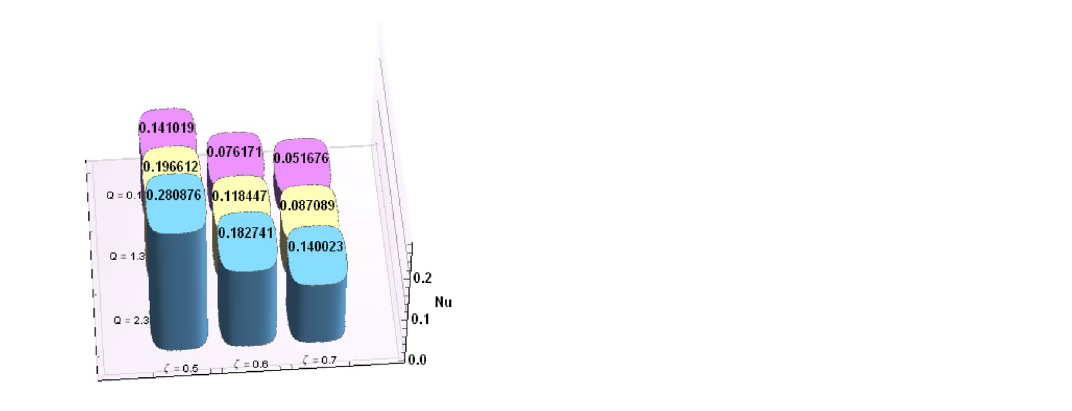
Figure 11. Bar chart representation of Skin friction coefficient and Nusselt number for different parameters using Mathematica 10 software available at (https:// softa sm. com/ wolfr am- mathe matica- 10-4- full- crack/). Nu versus